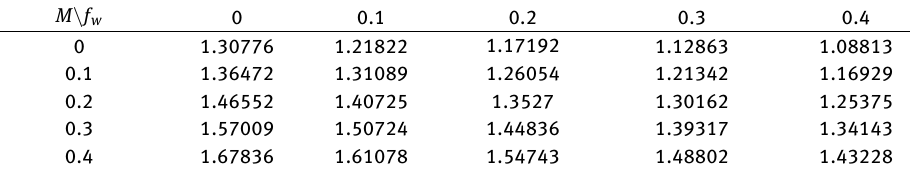
Table 3: Illustrating the variation of f (cid:48)(cid:48) (0) for various M and f w at the approximation level m = 9 ( (cid:126) = −0.29, α = 0, We = 0, λ = 0)